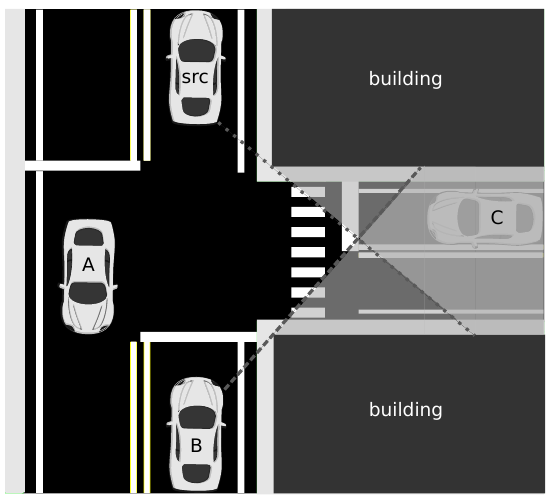
Figure 1. The shadowing problem in urban